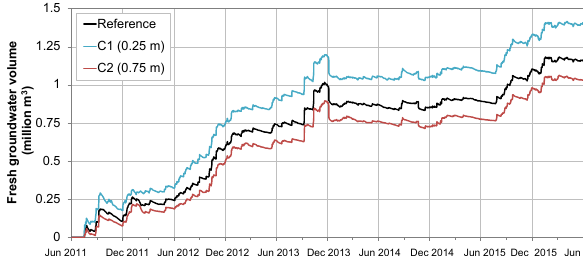
Figure 14. Increase in the fresh groundwater volume from June 2011 until May 2016, with the calibrated model with an extinction depth of 0.5m (Sect. 2.5.3), a 50% decreased extinction depth of 0.25m (C1), and a 50% increased extinction depth of 0.75m